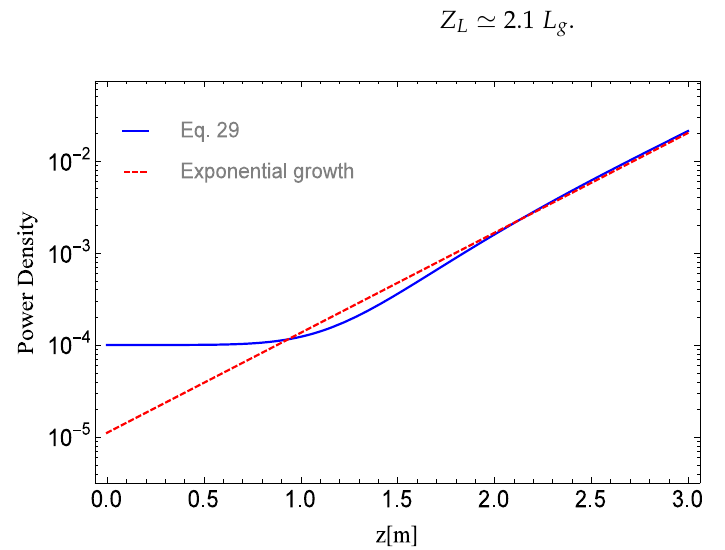
Figure 3. Comparison between Equation (29) and the pure exponential behavior for L g =